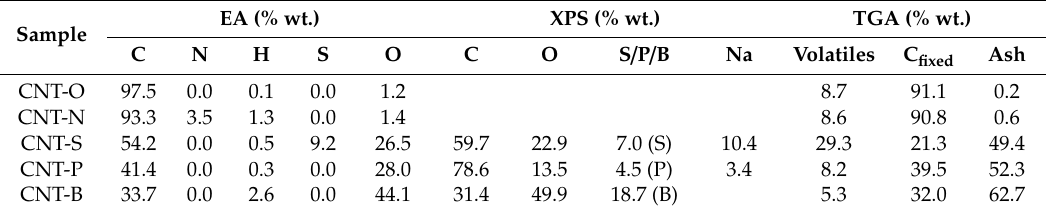
Table 3. Bulk characterization by elemental analysis (EA) and surface chemistry characterization by X-ray photoelectron spectroscopy (XPS) and thermogravimetric (TGA) analyses of pristine and mechanothermally treated carbon nanotubes (CNT) samples.